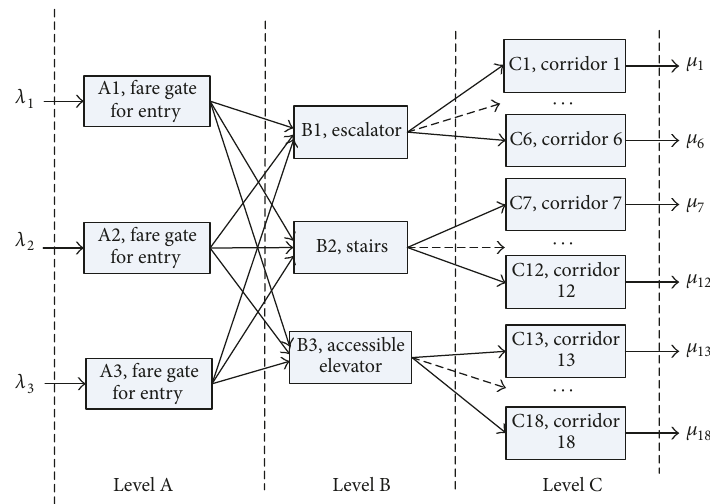
Figure 5: Queuing network of QiBao